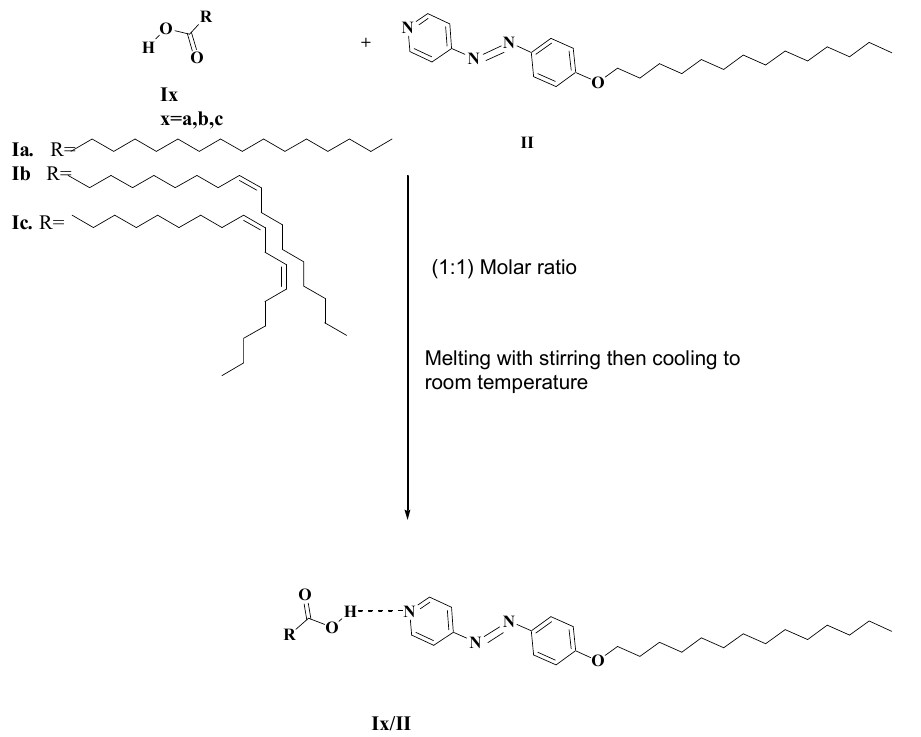
Scheme 1. Steps of formation of 1:1 SMHB complexes ( Ix/II ).